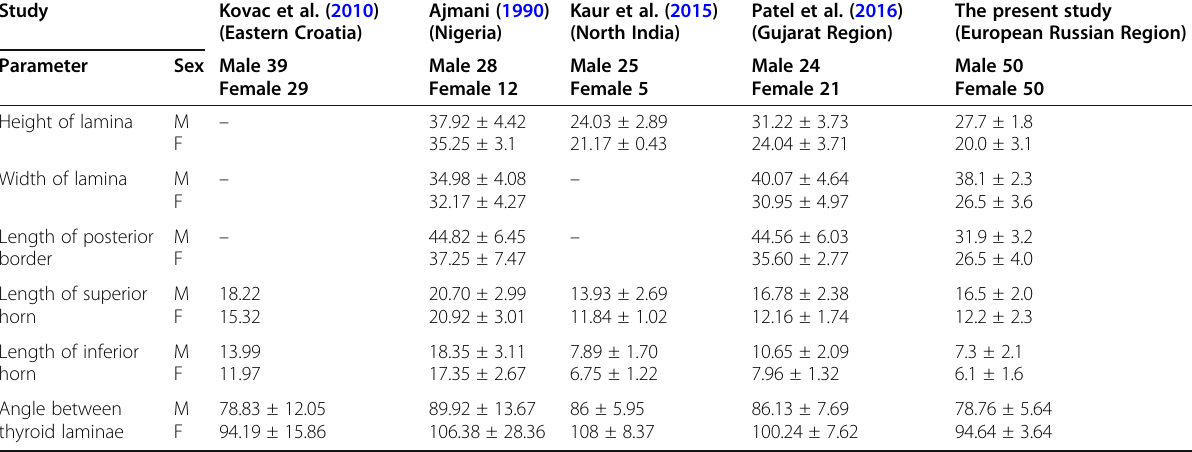
Ajmani (1990) Kaur et al. (2015) Patel et al. (2016) The present study (Nigeria) (North India) (Gujarat Region) (European Russian Region)